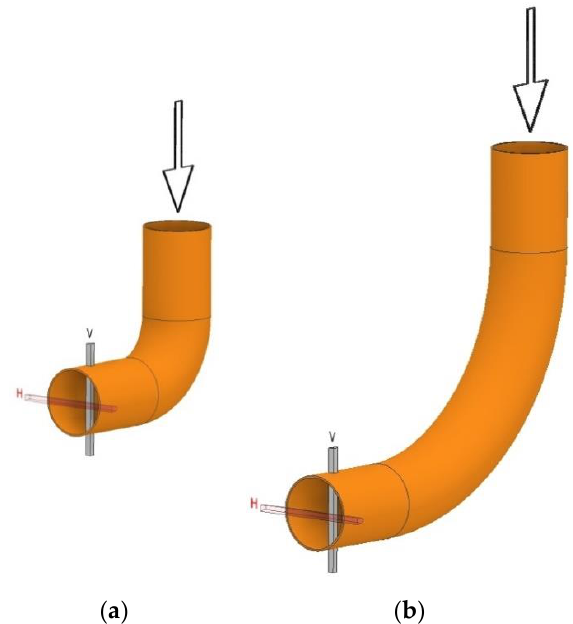
Figure 4. Single-elbow flow system of different curvatures (arrows mark the direction of flow) ( a ) R c = 1D, ( b ) R c = 3D.